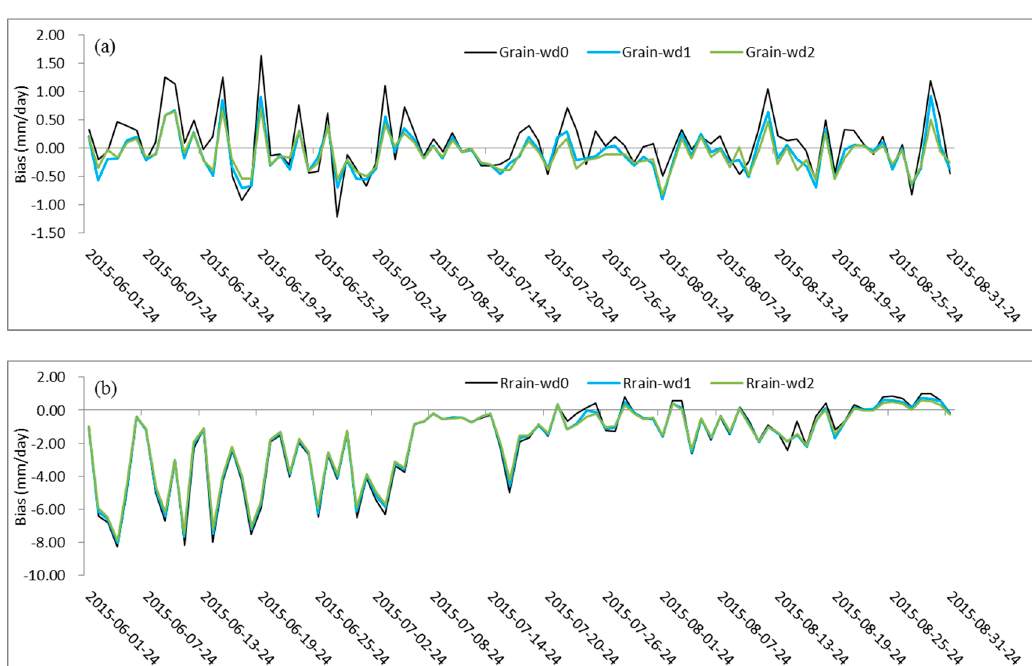
Figure 16. Same as Figure 14, but for bias.